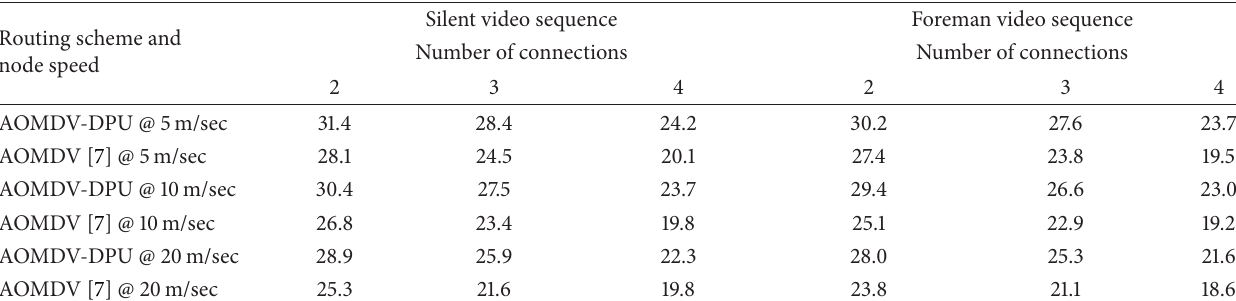
Table 4: Average PSNR (in dB) for Silent and Foreman video encoded at 256